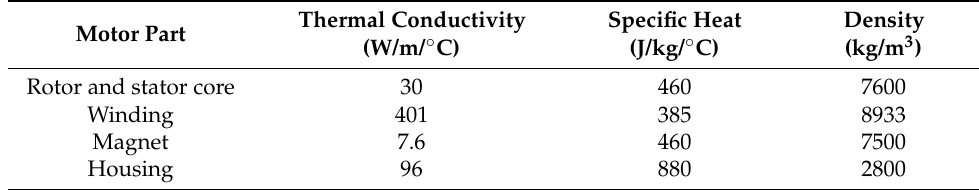
Table 7. Material Properties for Thermal Analysis.